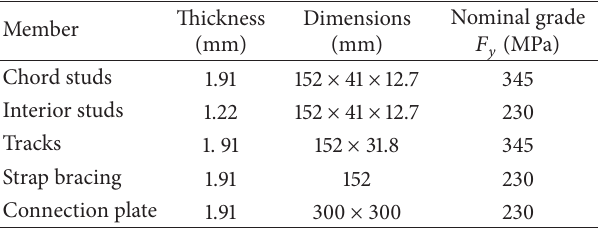
Table 1: Dimension sections and material properties.